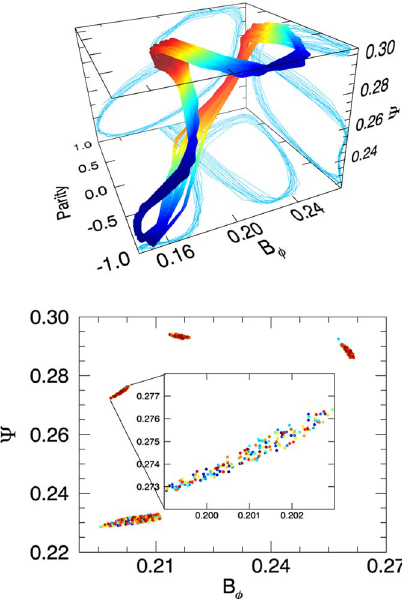
Fig. 5. Top panel: 3D phase portrait between parity, toroidal magnetic fi eld and the shear proxy (see Eq. (14)) from solution 2. Each of these three quantities is extracted at r / R = 0.85 and 15 (cid:3) latitude. Only the modulation envelope of those quantities is used for plotting, i.e., the primary cycle is removed. The color code represents the magnitude of the parity from (cid:3) 1 in blue to +1 in red. The bottom panel is a Poincaré section in the P = 0 plane, with the inset focusing on one of the four crossing locations. The trajectory therein is space- fi lling, indicating that the modulation is chaotic (see